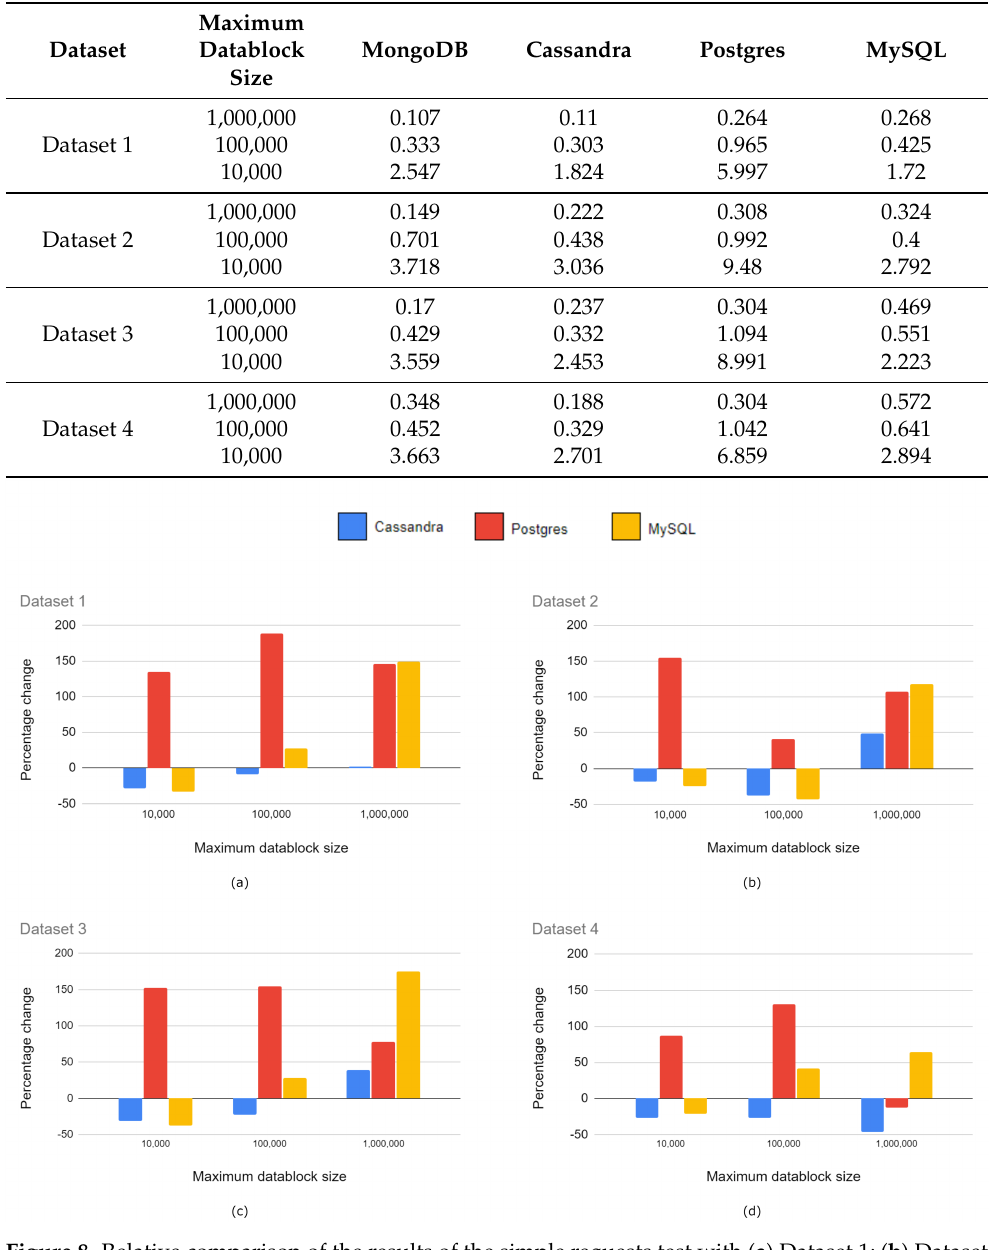
Figure 8. Relative comparison of the results of the simple requests test with ( a ) Dataset 1; ( b ) Dataset 2; ( c ) Dataset 3; and ( d ) Dataset